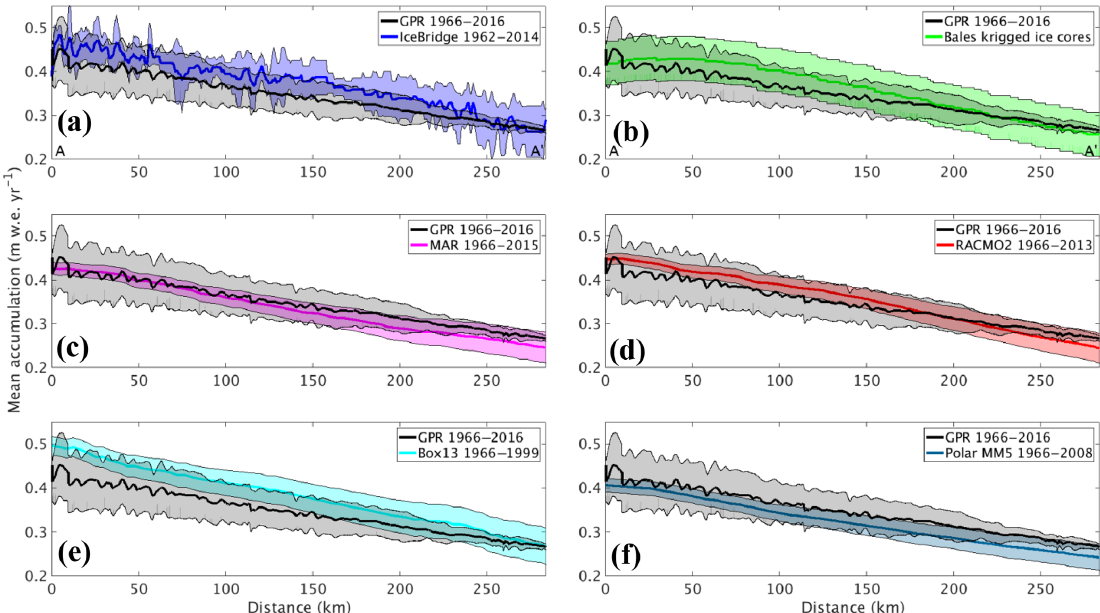
Figure 7. Average GreenTrACS GPR accumulation rates (black) compared with (a) IceBridge accumulation radar, (b) Bales09 kriged ice core map, (c) MAR, (d) RACMO2, (e) Box13, and (f) Polar MM5. GPR measurements are statistically indistinguishable from each of the other measurements along this 285km transect in the dry snow zone ( A – A (cid:48) in Fig.